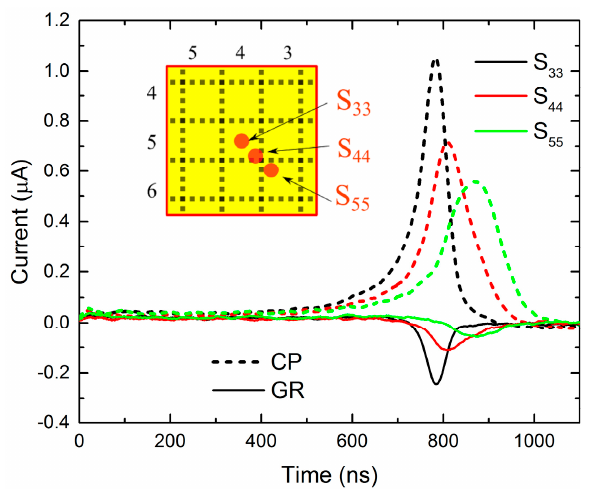
Figure 6. Individual current waveforms measured on CP and GR when illuminating different spots at 400 V bias. 400 V bias.